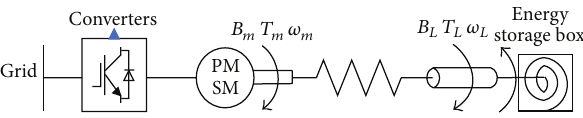
Figure 1: The model of PMSM based MEES